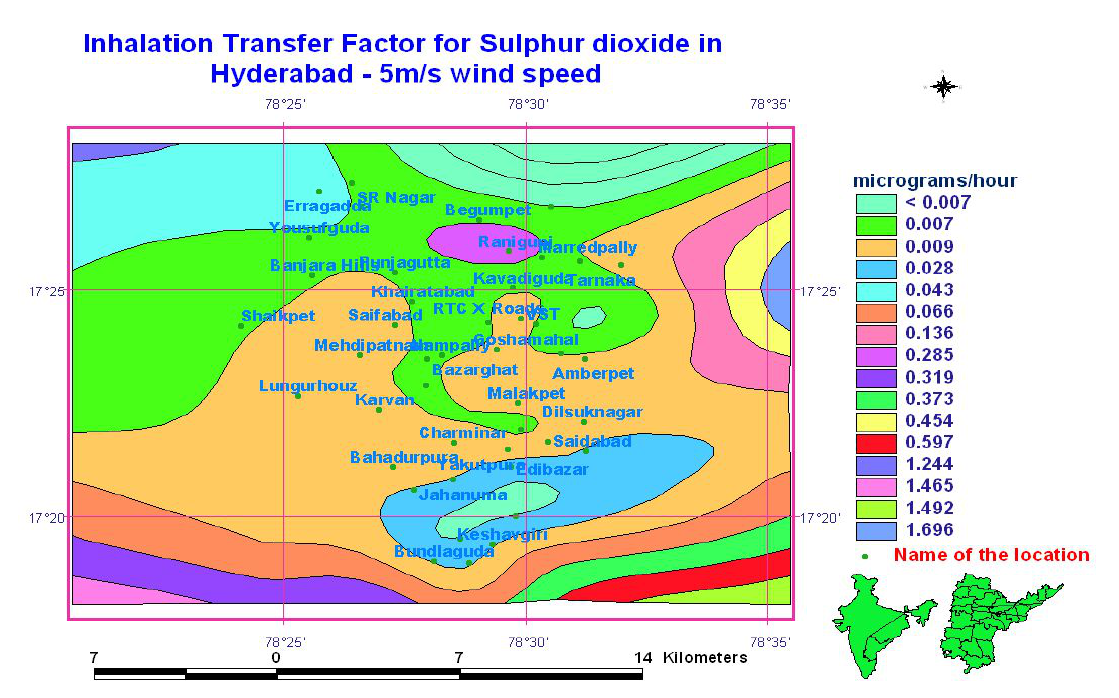
Figure 9: Inhalation transfer factor sulfur dioxide in Hyderabad – wind speed